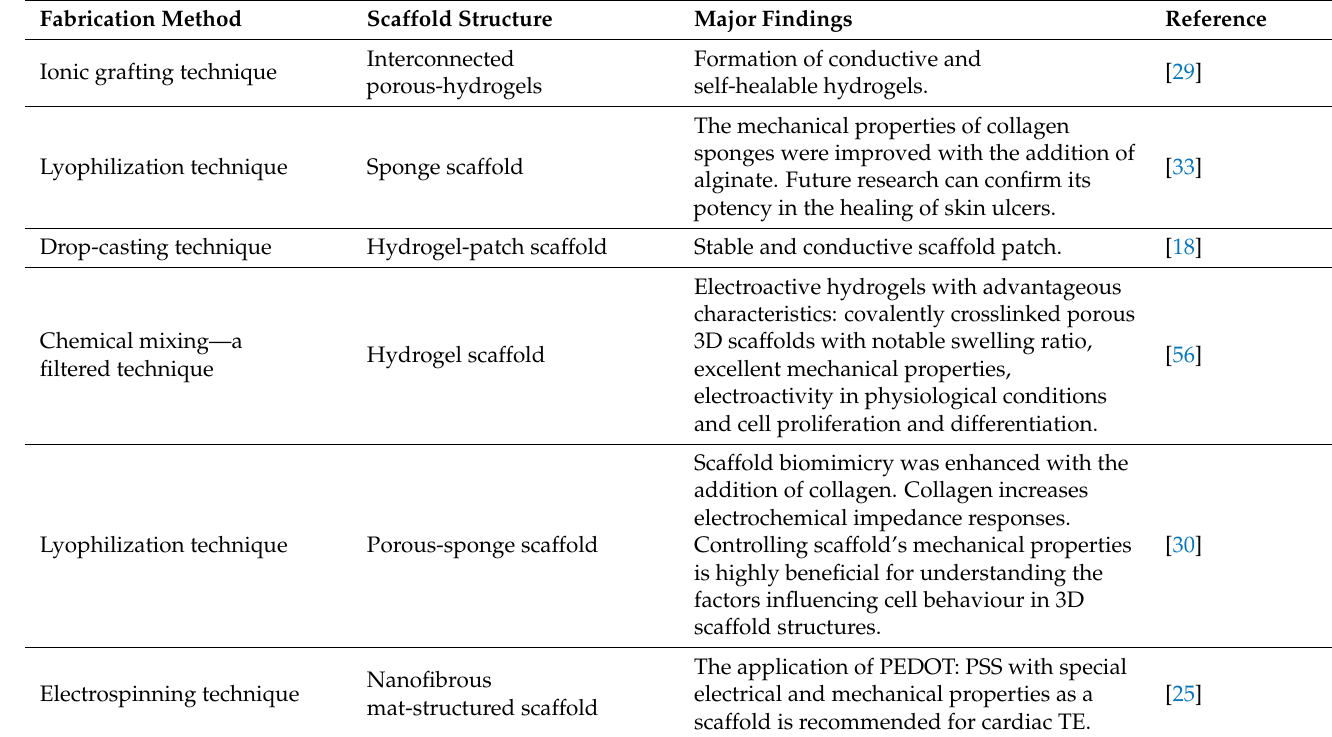
Table 1. Summary of scaffold fabrication